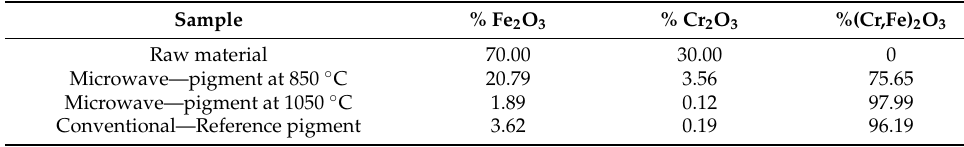
Figure 3. ( A ) Left: raw material mixture; Center: pigment obtained after microwave process, Right: pigment obtained after conventional process (reference pigment); ( B ) XRD patterns of a: raw material mixture, b: microwave-processed sample at 850 °C, c: microwave-processed sample at 1050 °C and d: reference pigment. Table 1. Phase composition of the different